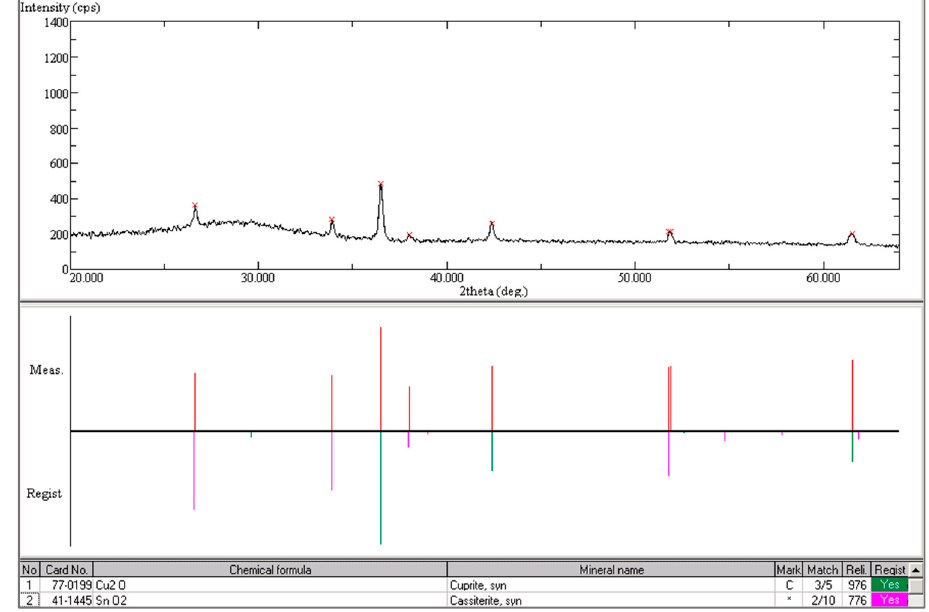
Figure 41. BSE images of “dullish” red-colored glass (KH_R1 natron-based Egypt I glass tessera from Khirbet al-Mafjar, Palestine [23]), showing the micro-textures of the vitreous matrix ( a ), dotted with regularly distributed nanometric rounded particles ( b ).